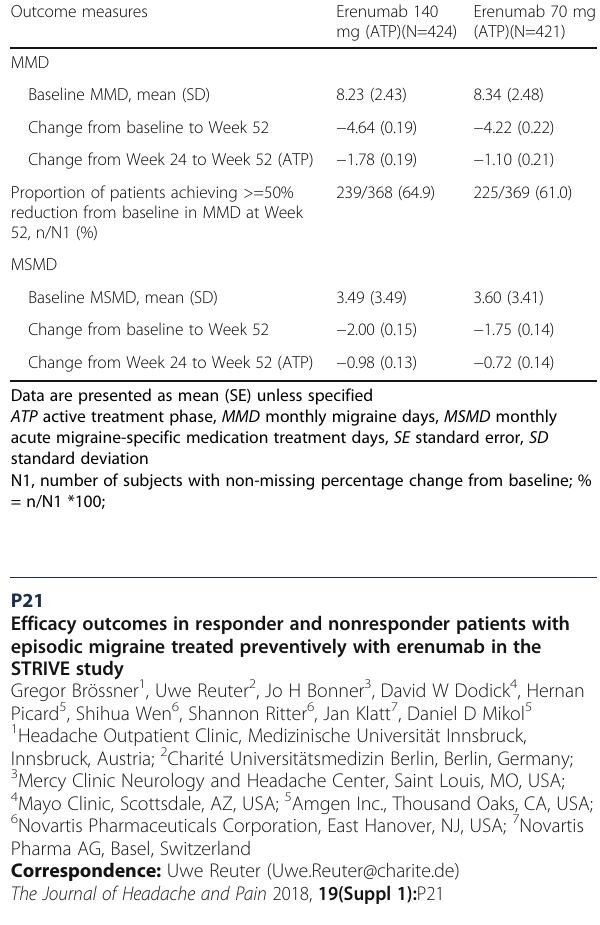
Table 1 (abstract P20). Outcome measures